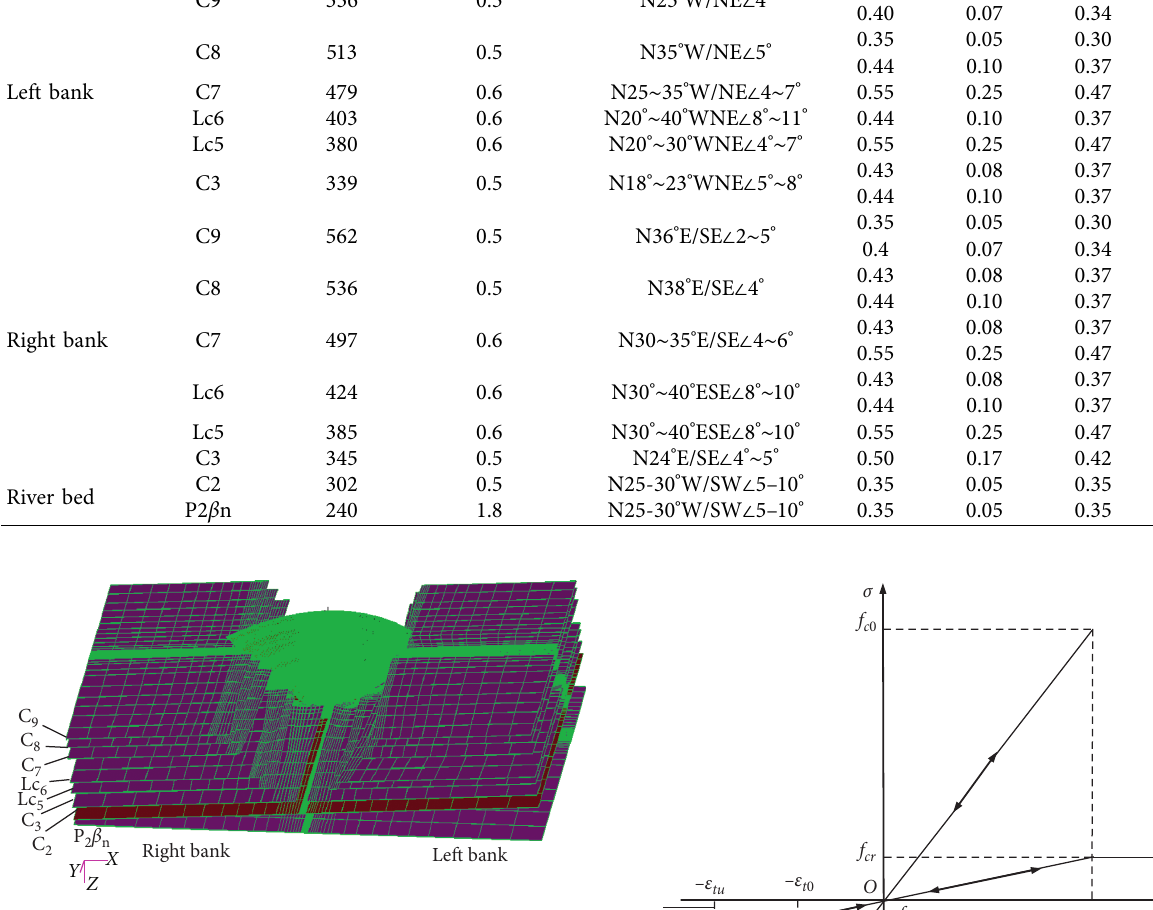
Figure 3: Relationship between the dislocation zone and the dam body in the interlayer.